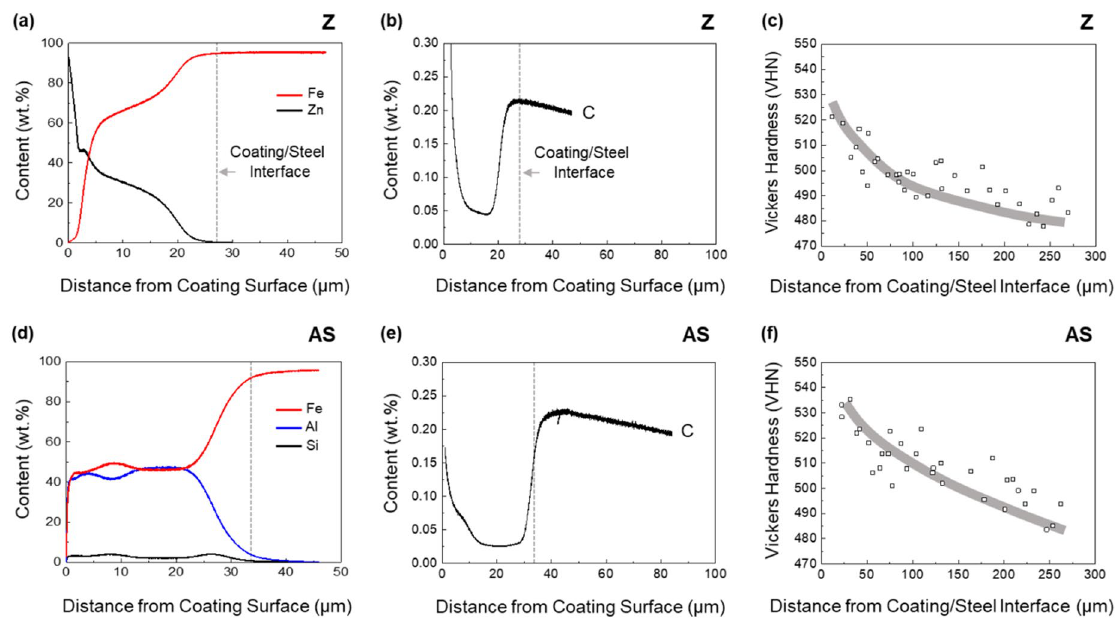
Figure 3. ( a , b , d , e ) Glow discharge spectrometer (GDS) data of Fe, Zn, Al, Si, and C contents as a function of distance from the coating surface in the Z and AS steels. ( c , f ) Shows Vickers hardness data (indentation load; 100 g) from the interface to the